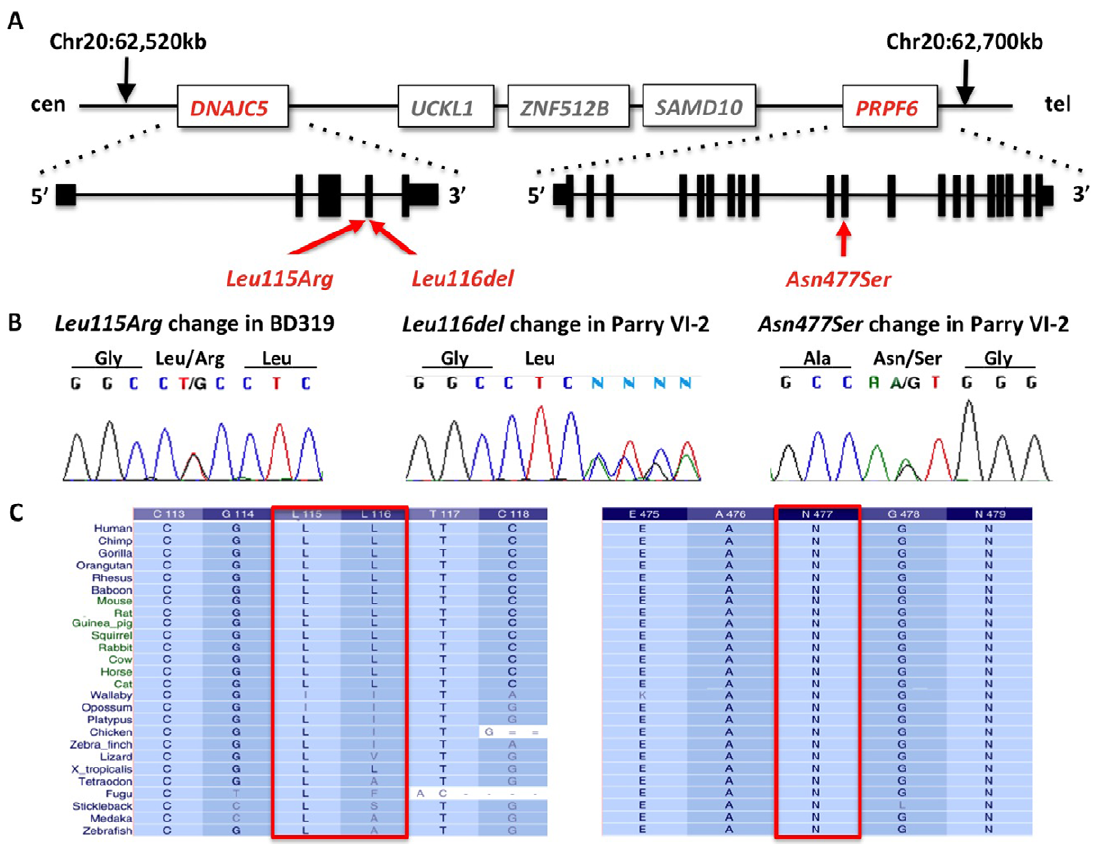
Figure 3. Identification of DNA variants in DNAJC5 and PRPF6 . a) Schematic of the region on chromosome 20 containing DNAJC5 and PRPF6 in close proximity. b) Sanger sequence traces of the identified segregating variants in DNAJC5 and PRPF6 . c) The two very rare changes identified in the Parry family Leu116del (in DNAJC5 ) and N477S (in PRPF6 ) were highly conserved in different species. A second change in DNAJC5 , Leu115Arg, was also highly conserved.